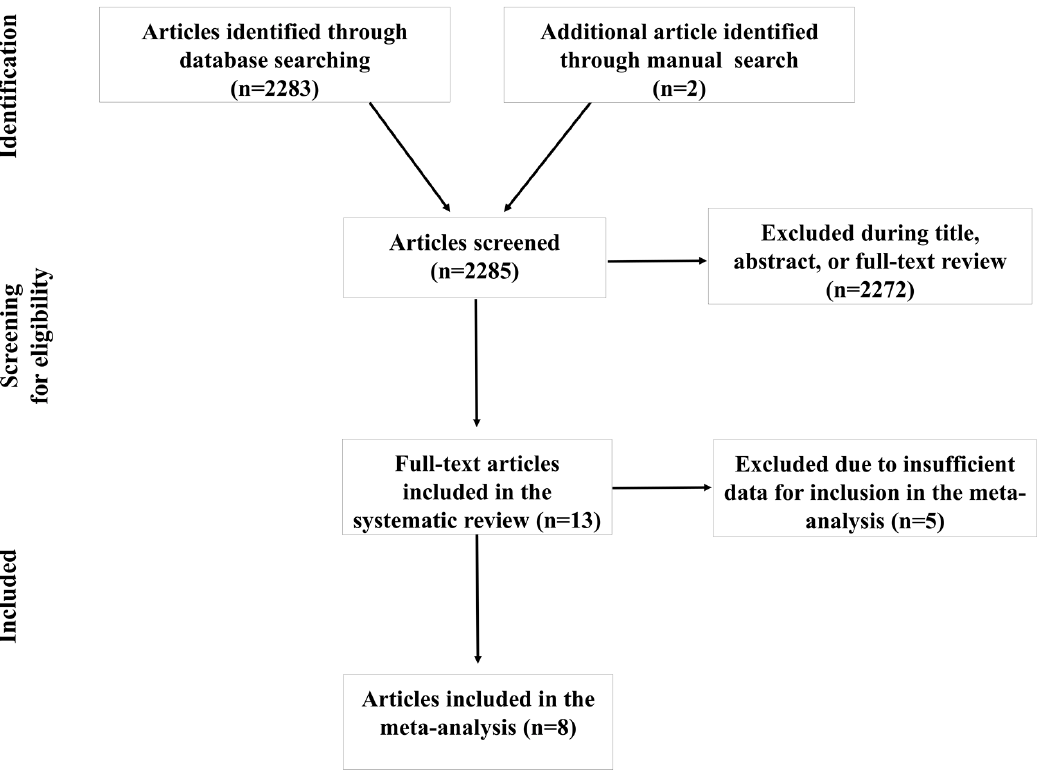
Figure 1. Article selection flow chart.